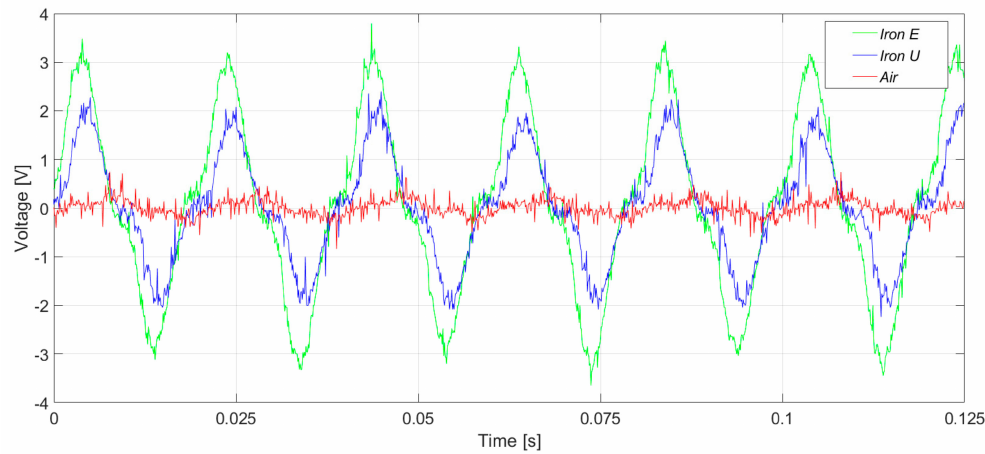
Figure 15. Induced voltage measurement with a 2% inter-turn stator fault severity, in the upside position.